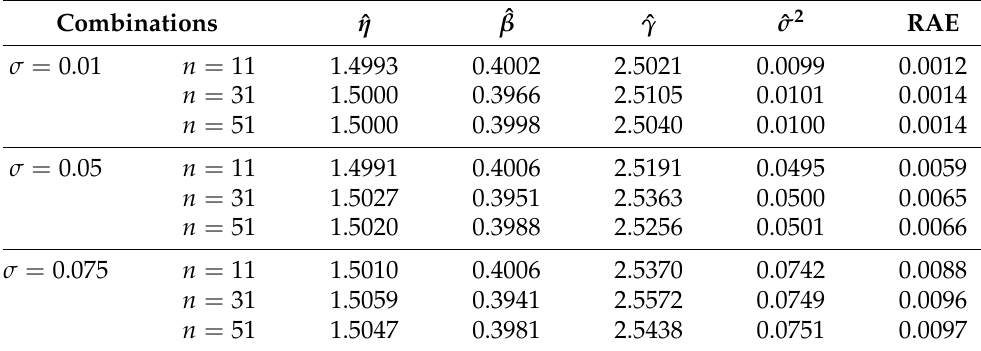
Table 3. Final solutions for simulated data of the H 2 process and RAE to estimated mean. Original parameters are η = 1.5, β = 0.4 and γ = 2.5.